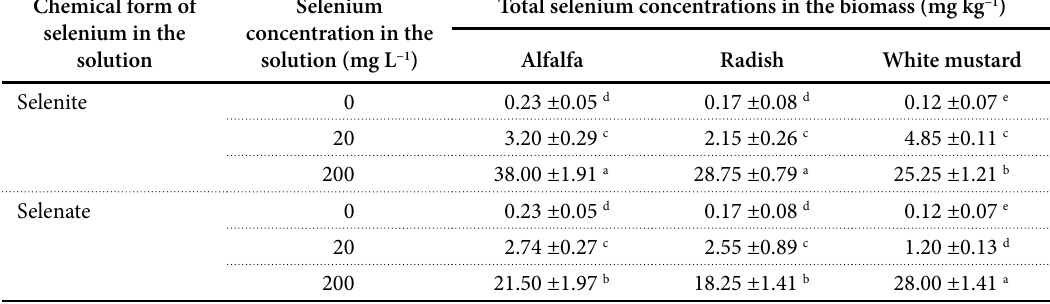
Means (± SD ; N = 4) in each column with different letters are significantly different ( p < 0.05) according to Tukey’s LSD